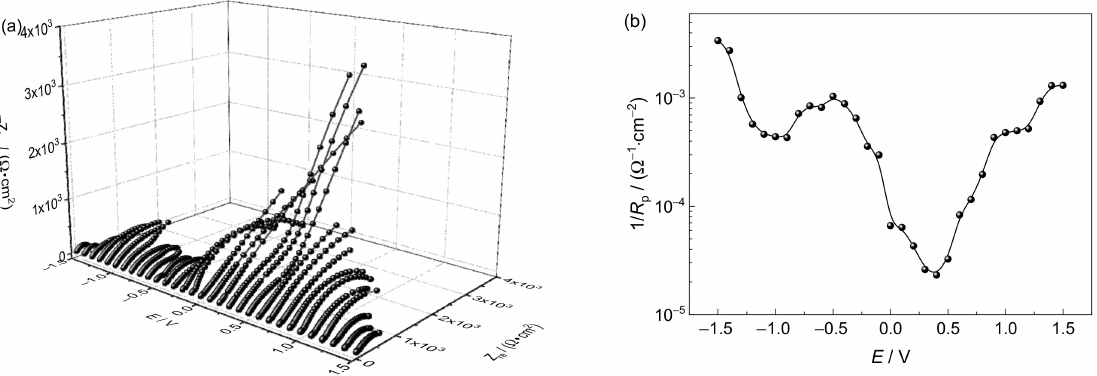
Figure 14. Dynamic electrochemical impedance spectroscopy plot ( a ) and lg(1/ R p )– E curve ( b ) in a simulated deep–sea environment.